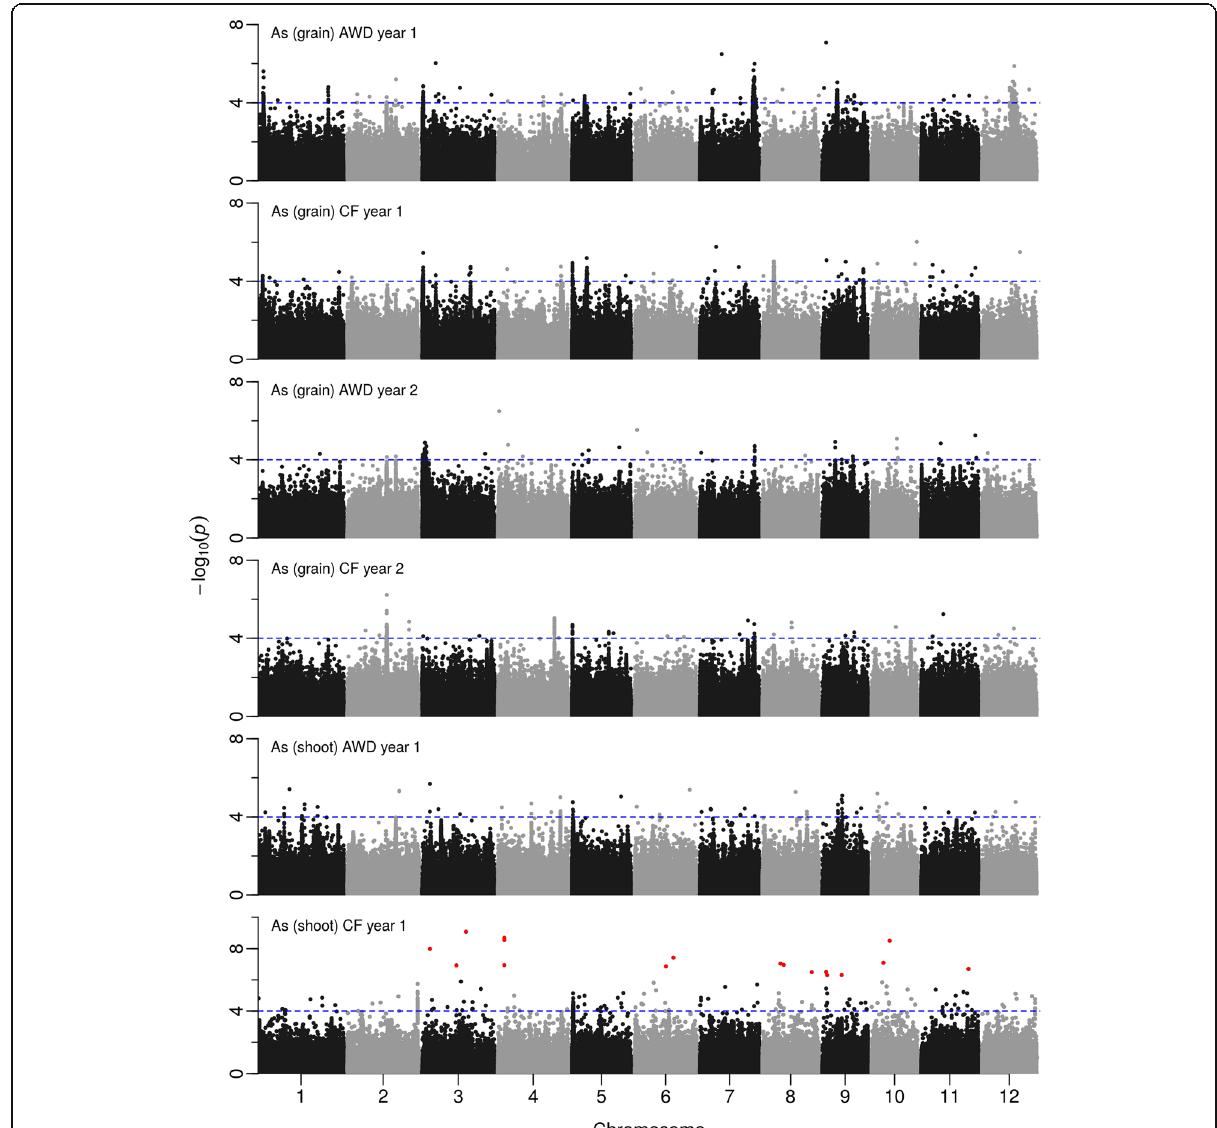
Fig. 2 Manhattan plots from GWA mapping of shoot and grain arsenic in field experiments under AWD (Alternate Wetting and Drying) and CF (Continuous Flooding) over years 1 and 2. A guide-line in blue is shown at -log10(0.0001) = 4. Benjamini-Hochberg adjusted probabilities > 0.1 are highlighted in